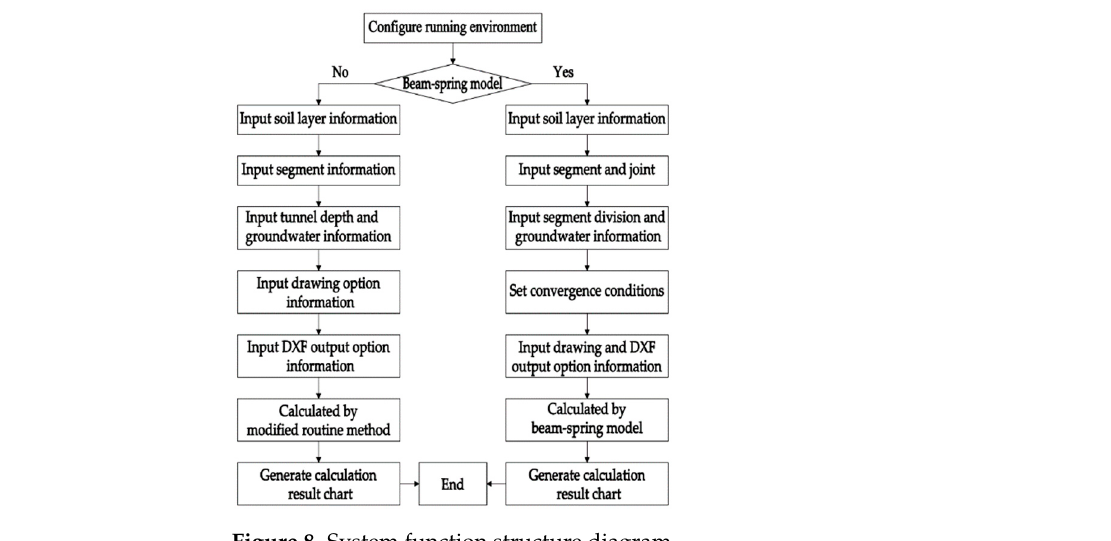
Table 1. Main design parameters of shield segment.